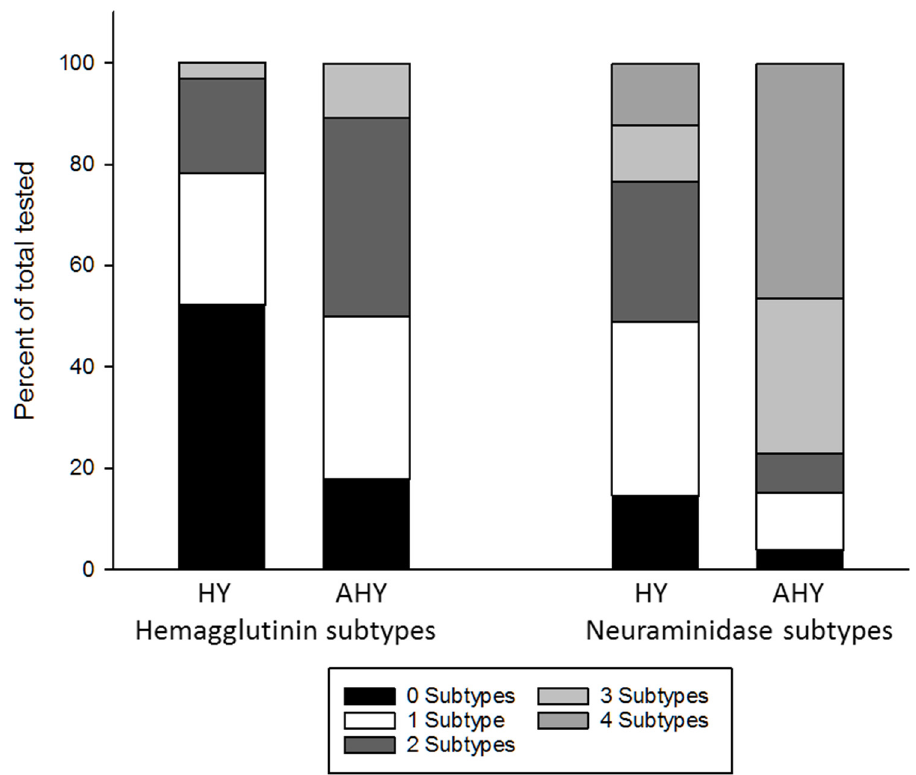
Figure 2. Percentage of tested hatch-year (HY) and after-hatch-year (AHY) influenza A virus nucleoprotein antibody-positive mallards testing positive to 0, 1, 2, or 3 of 3 hemagglutinin (H3, H4, H5) and 0, 1, 2, 3, or 4 of 4 neuraminidase (N1, N2, N6, N8) subtypes.